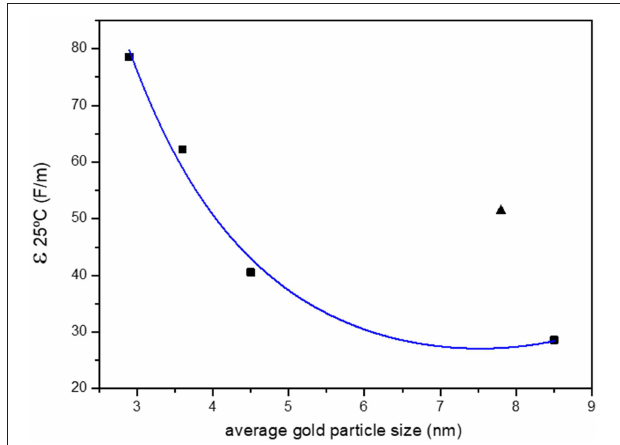
FIGURE 3 | Relationship of the average particle size with the dielectric constant of the solvent.